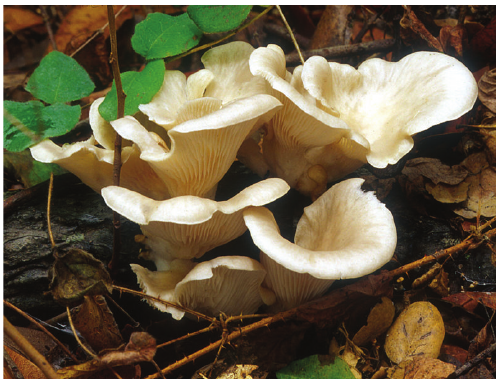
Figure 1: Image of mushroom Pleurotus florida